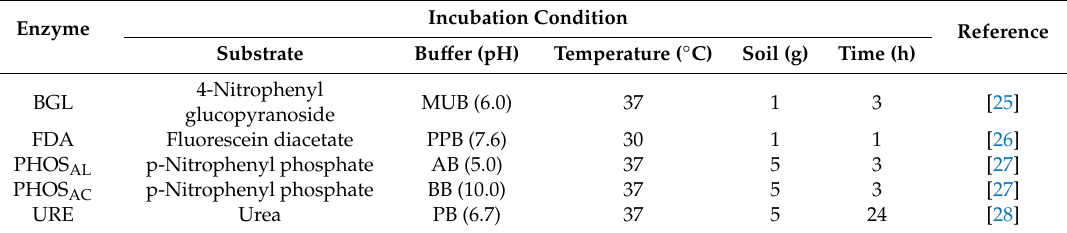
Table 1. Incubation condition of enzymes used with biochemical